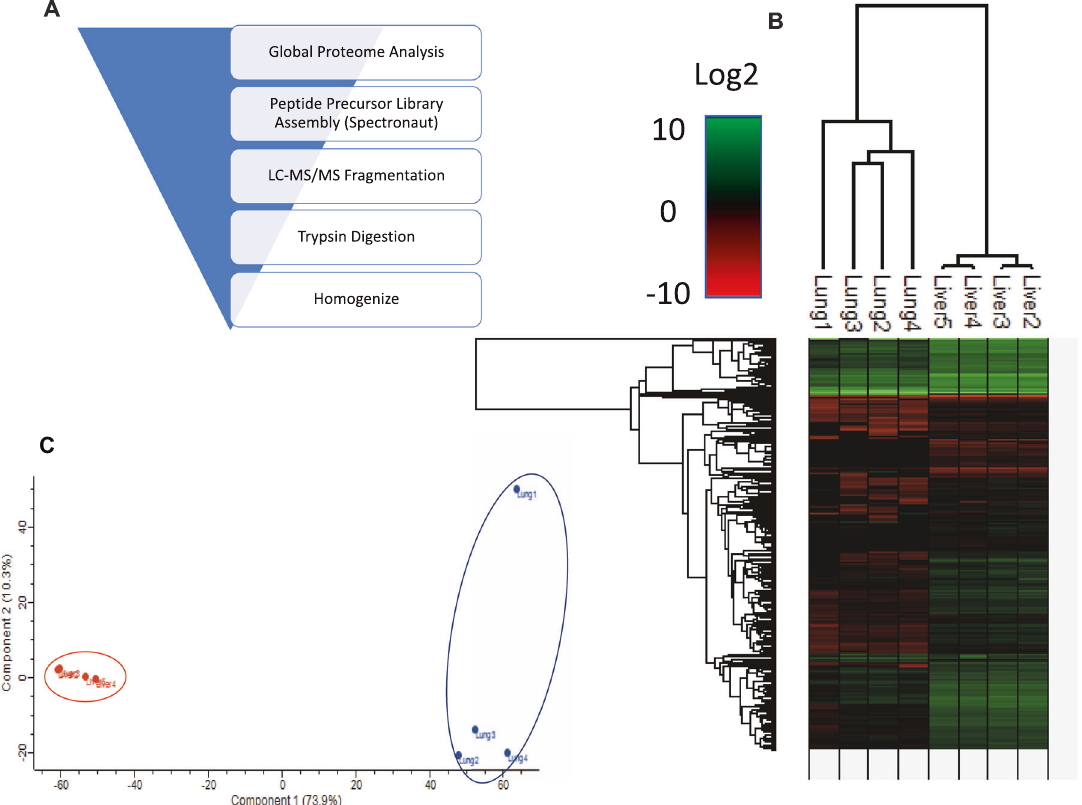
Fig. 1 LC-MS/MS proteomics work fl ow, principal component analysis, and hierarchical clustering. SWATH-MS bottom-up proteomics was used to quantify protein abundance using the total protein approach from data handled by Spectronaut ( A ). Euclidean distance hierarchical clustering ( B ) showed tissue metastasis-speci fi c proteomes with liver metastases appearing to contain more proteins than those from lung. Principal component analysis further con fi rmed tissue-speci fi c clustering based on their quanti fi ed proteome ( C